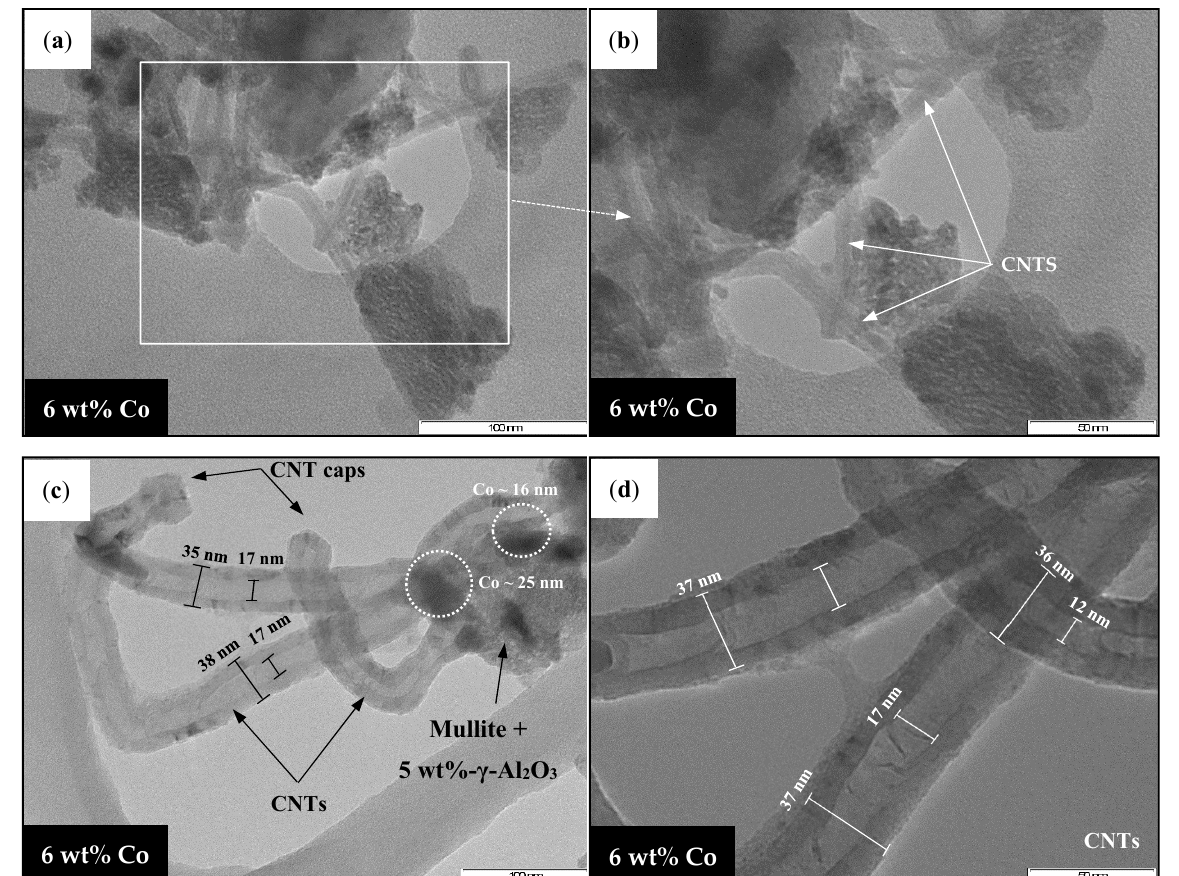
Figure 23. TEM micrographs of carbon nanotubes (CNTs) detected on the used catalyst; ( a – d ) 6 wt% Co.